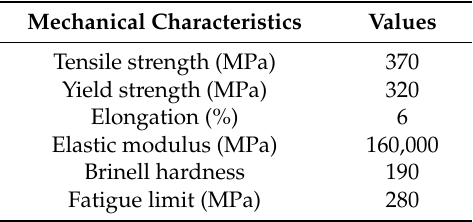
Table 2. Mechanical properties of ductile cast